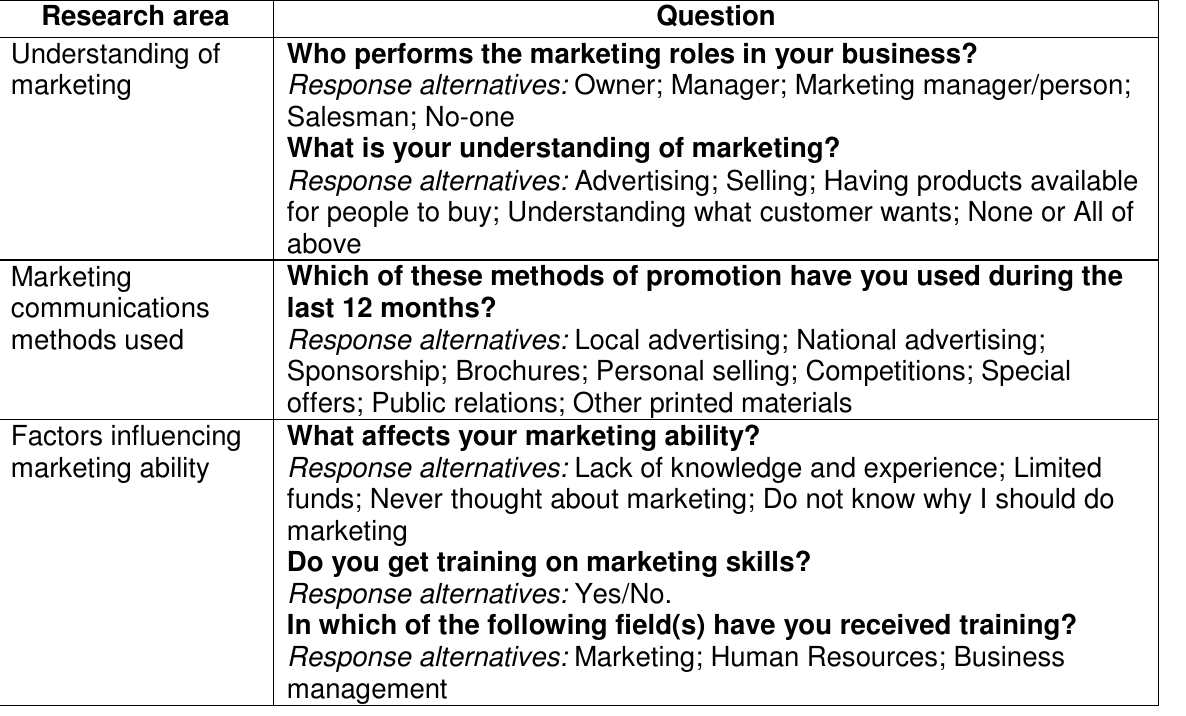
Table 2: Summary of key questions Research area Question Understanding of